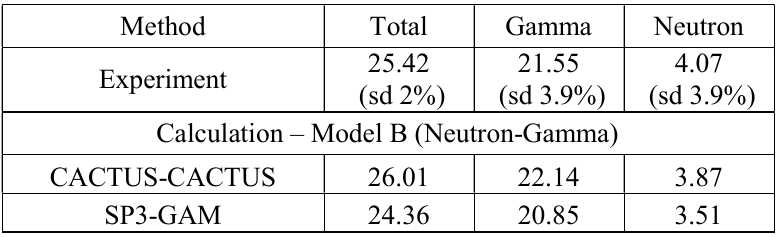
Table V. Heating for the Improved Model B (micro W/g) : Graphite